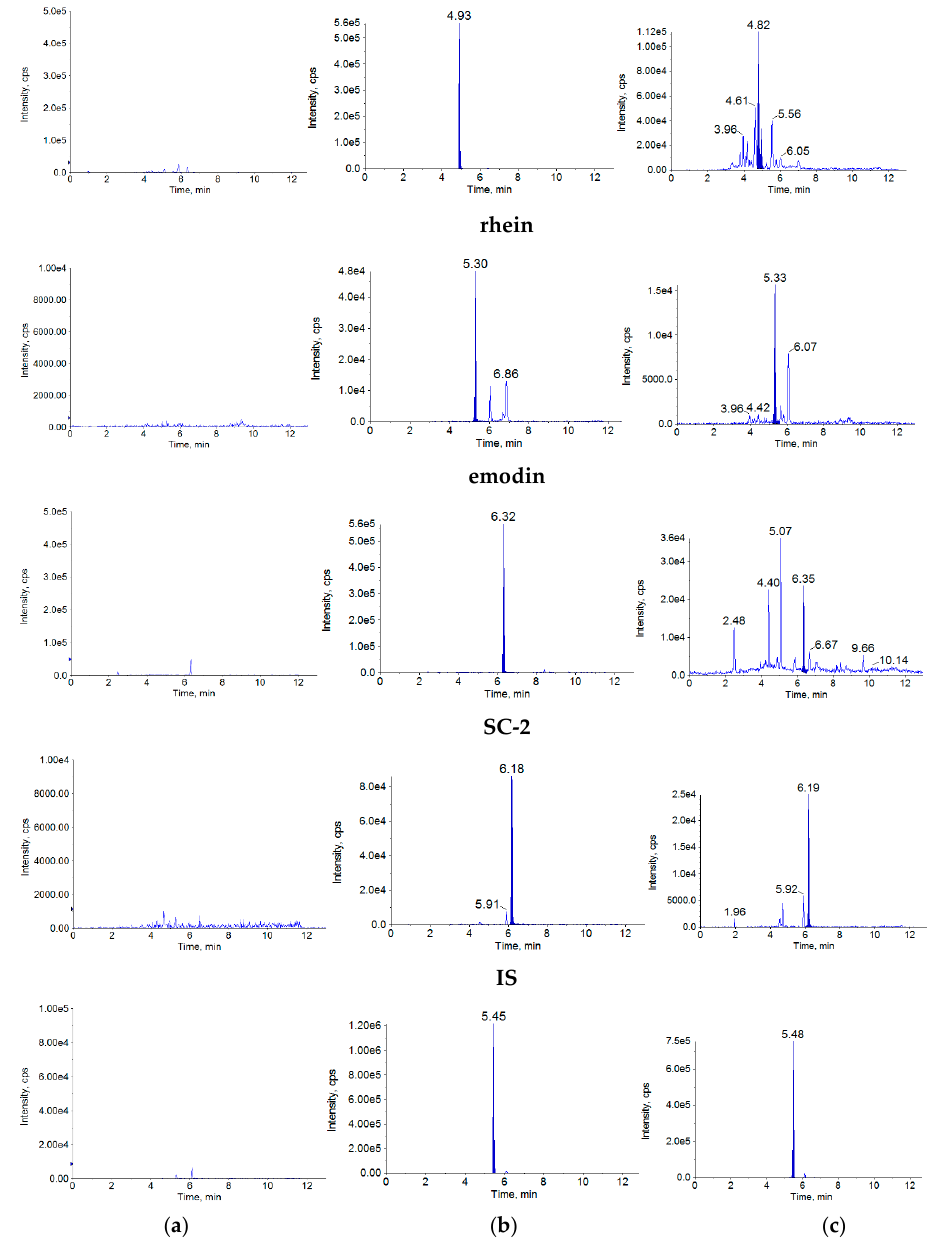
Figure 2. MRM chromatograms of the analytes in rat plasma: blank plasma ( a ), blank rat plasma spiked with the analytes and IS ( b ) and plasma samples taken from rats at 30 min after oral administration of R-SC extract ( c ).